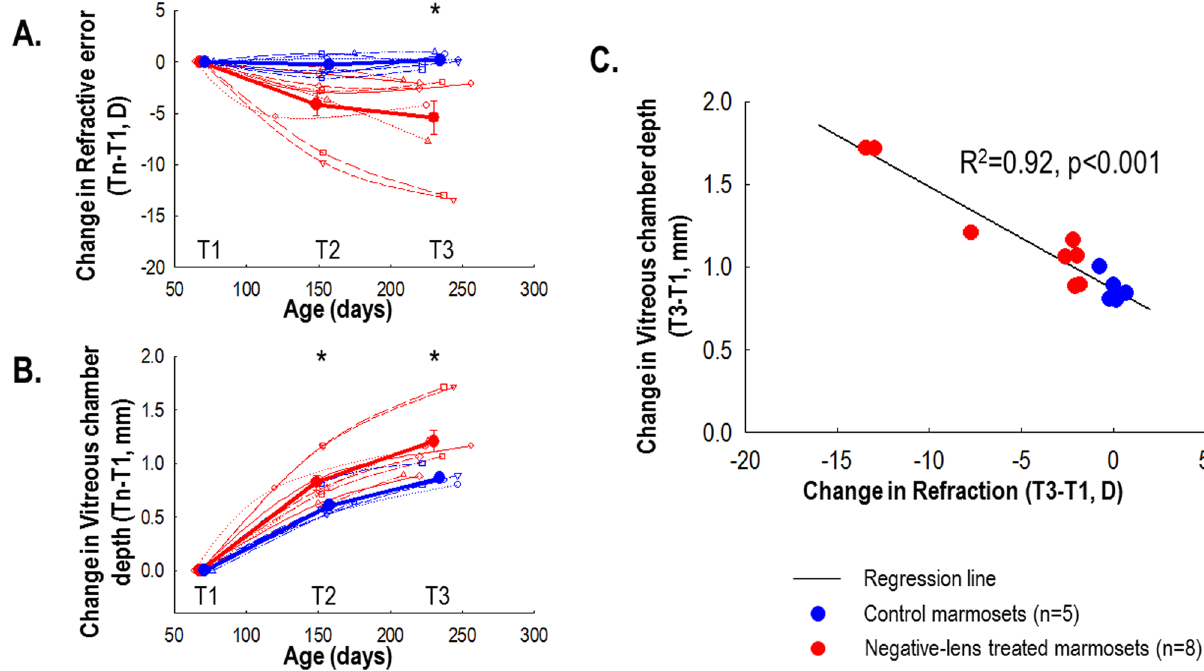
Figure 5. ( A ) Refractive error changes and ( B ) vitreous chamber depth changes, normalized to baseline, for control and negative-lens treated eyes in each group over the treatment duration. Unfilled thin symbols represent data for the individual marmoset whiles thick filled circles represent the mean for each group: control (blue) and negative-lens treated (red). Positive and negative values on the ordinate of Fig. 3A represent hyperopic and myopic refractive change relative to baseline, respectively. Statistically significant differences at each treatment time point are indicated by * p < 0.05. The data are shown as mean ± SE. ( C ) Change in vitreous chamber depth as a function of change in refraction after 22 weeks of treatment. Solid black line represents the regression line, while blue and red symbols are data for control and negative-lens treated marmosets,